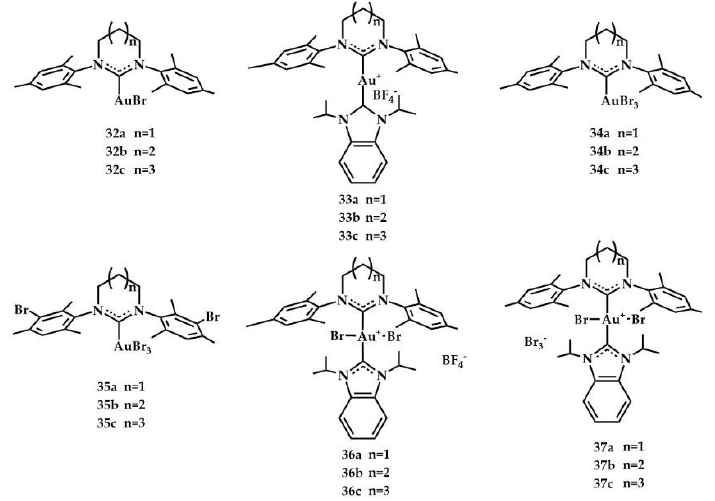
Figure 15 . Complexes synthesized by Huynh et al. [31]. Figure 15. Complexes synthesized by Huynh et al. [31].